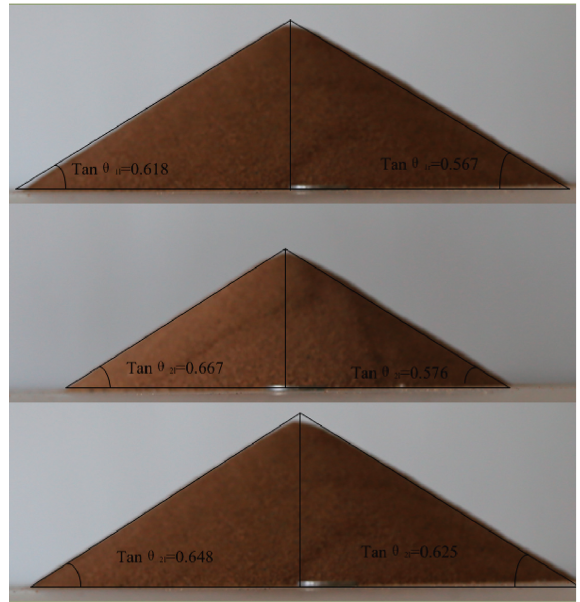
Figure 5: Test of friction